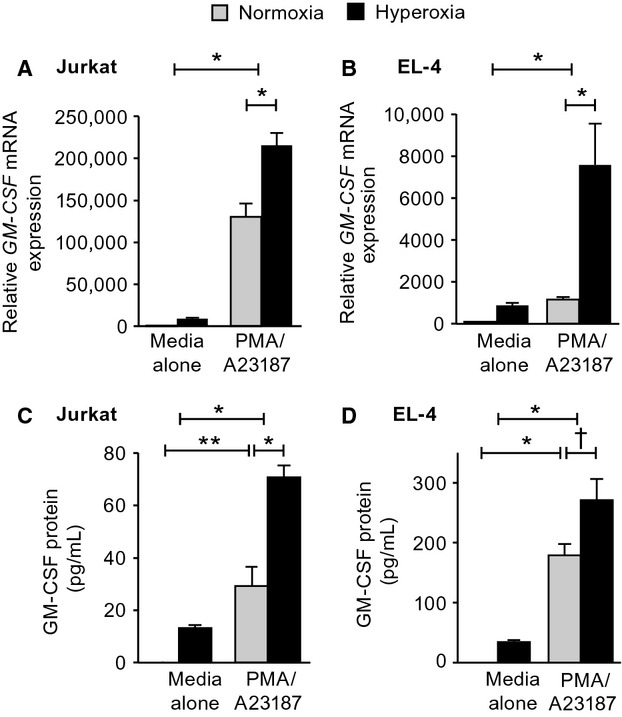
Effect of exposure to hyperoxia on expression of GM-CSF by T-cell lines. Human (Jurkat) and mouse (EL4) T cells were exposed to hyperoxia (80% oxygen/5% CO2; black bars) or normoxia (21% oxygen/5% CO2; gray bars) for a total of 48 h. After 32 h, the culture medium was then replaced with media alone or media containing PMA/A23187 as described in Methods. The cells were continued in hyperoxic or normoxic conditions for 16 h further. GM-CSF mRNA was determined in cell lysates and GM-CSF protein measured in the culture supernatants. GM-CSF mRNA was assessed by RT-PCR, normalized to GAPDH levels and expressed relative to the first sample of normoxia (100%) (A and B). GM-CSF protein in the culture supernatants was measured by ELISA. Data are expressed as pg GM-CSF protein/ml (C and D). All data are expressed as means ± SEM, n = 3, and are representative of three independent experiments. *P < 0.001; **P < 0.01.